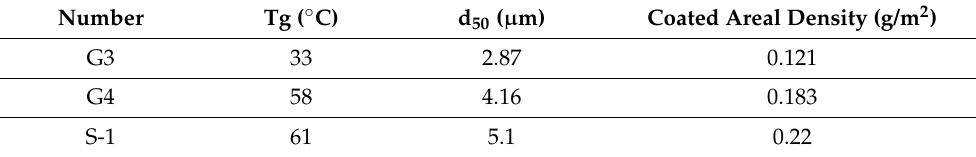
Table 3. The coated areal density of battery separator surface after wire rod coating.